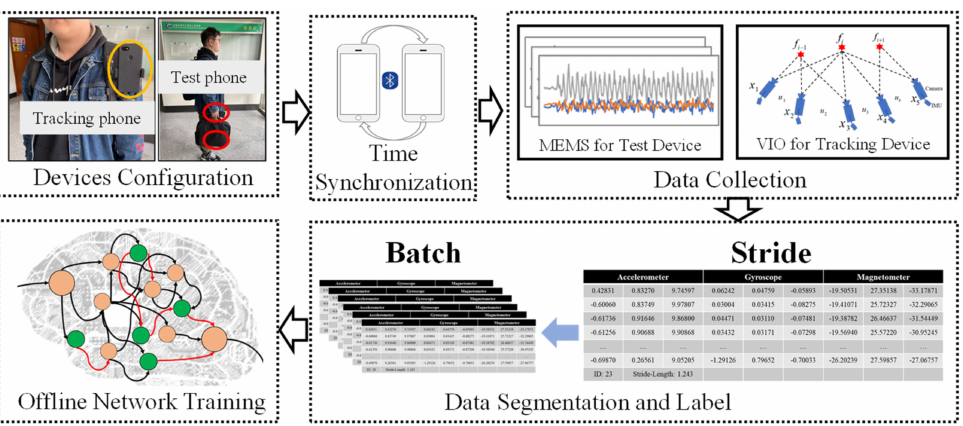
Figure 5. The framework of the vision − aided training data